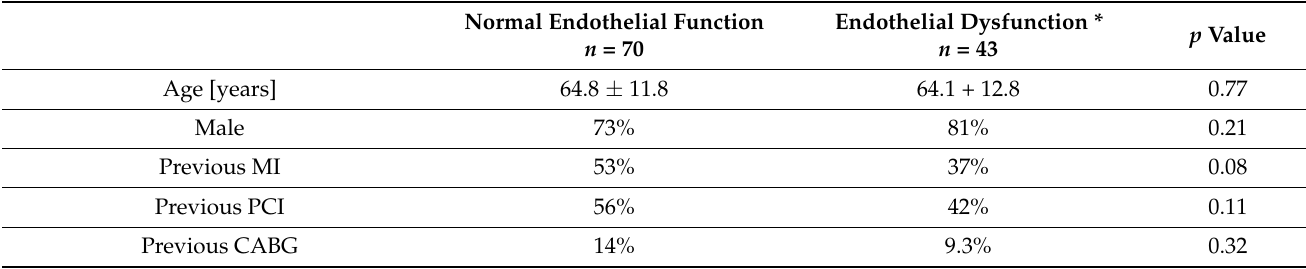
Demographics, comorbidities and pharmacotherapy in patients with and without endothelial